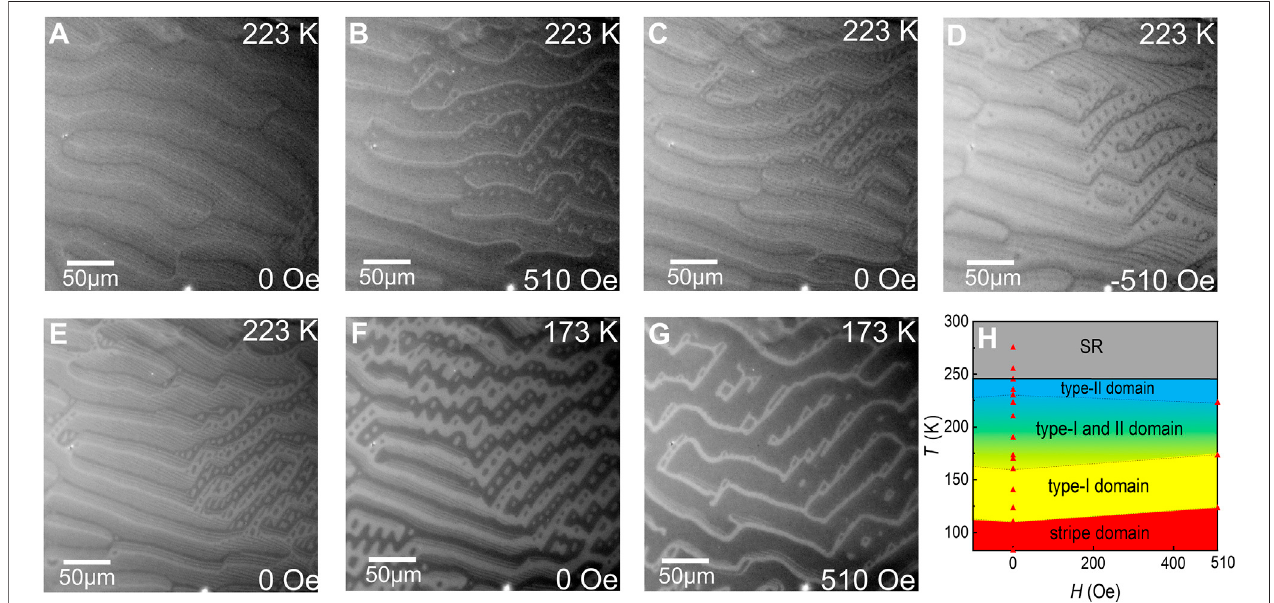
FIGURE4|(A – E) MagneticdomainsofDyMn 6 Sn 6 withvaryingmagnetic fi eldat223 K. (F – G) MagneticdomainsofDyMn 6 Sn 6 withvaryingmagnetic fi eldat173 K. (H) Phase diagram of magnetic domain distribution in DyMn 6 Sn 6 .